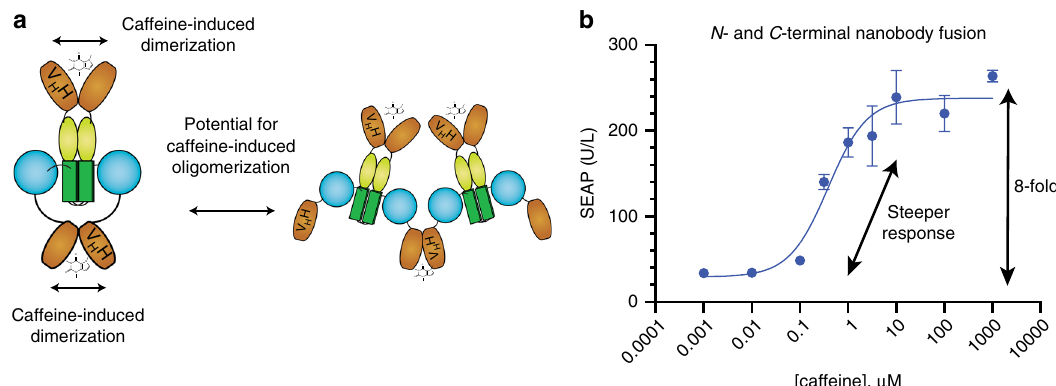
Fig. 6 Modulating cooperativity. a Schematic of the dual-ORK with an N-terminal and C-terminal acV H H fusion. Synergistic activation of ORK dimers by acV H H nanobodies or ORK oligomerization both have the potential to promote positive cooperativity. Both proposed mechanisms for the observed increase in cooperative behavior remain speculative at this point. b The dose – response curve of the dual-ORK. The plot shows the mean ± s.d. of n = 3 biologically independent samples, measured at 24 h after induction, and the results are representative of three independent experiments. Only error bars larger than the symbol size are displayed. Source data are provided as a Source Data fi le.